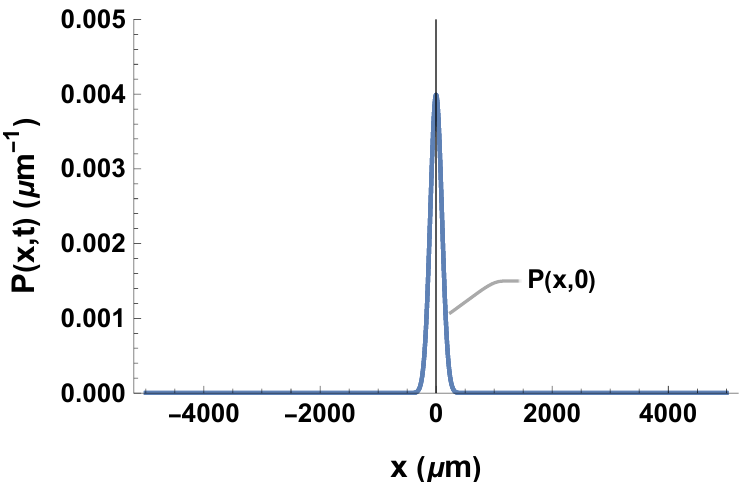
Figure 7. Simulation of MNP probability density function, P ( x , t ) , in both mucus and corn syrup after 24 h from simulation start. In the horizontal direction, only diffusion can affect P ( x , t ) , but, here, P ( x ,0 ) is not affected by passage of time. MNPs do not diffuse outward from their initial positions due to high fluid viscosity.